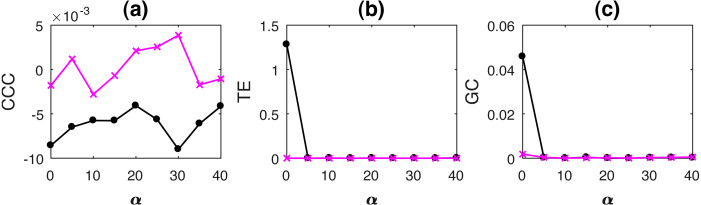
 Mean causality values estimated using CCC (A), TE (B) and GC (C) for coupled tent maps from Y to X (solid line-circles, black) and X to Y (solid line-crosses, magenta) as the percentage of non-uniform sampling is varied.CCC is able to distinguish the causality direction but the separation between values is small. TE and GC completely fail.